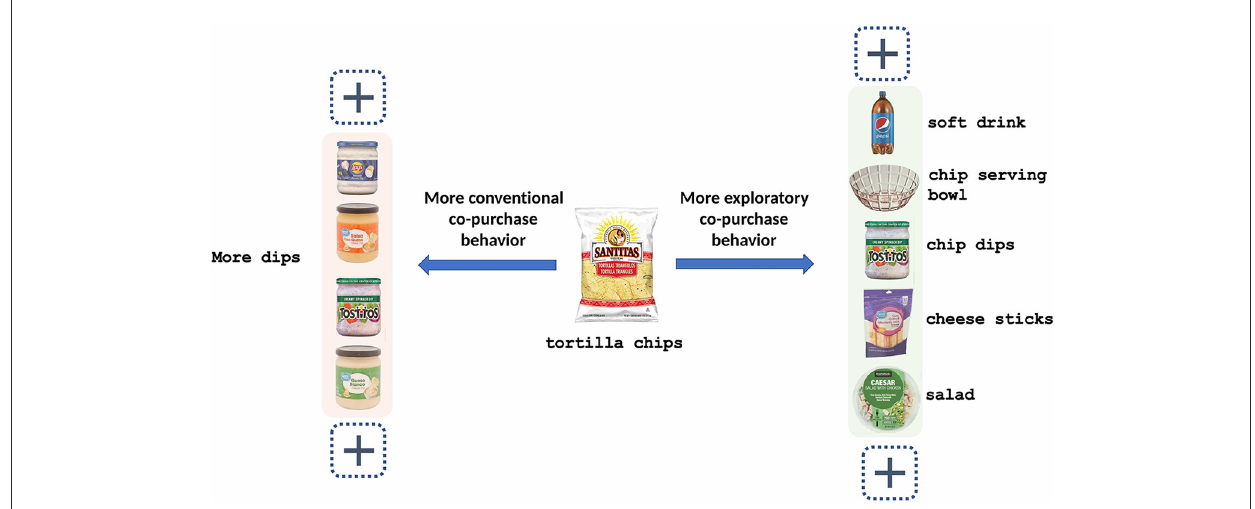
FIGURE1 Exploratory co-purchase behaviors vs. Conventional co-purchase behaviors.